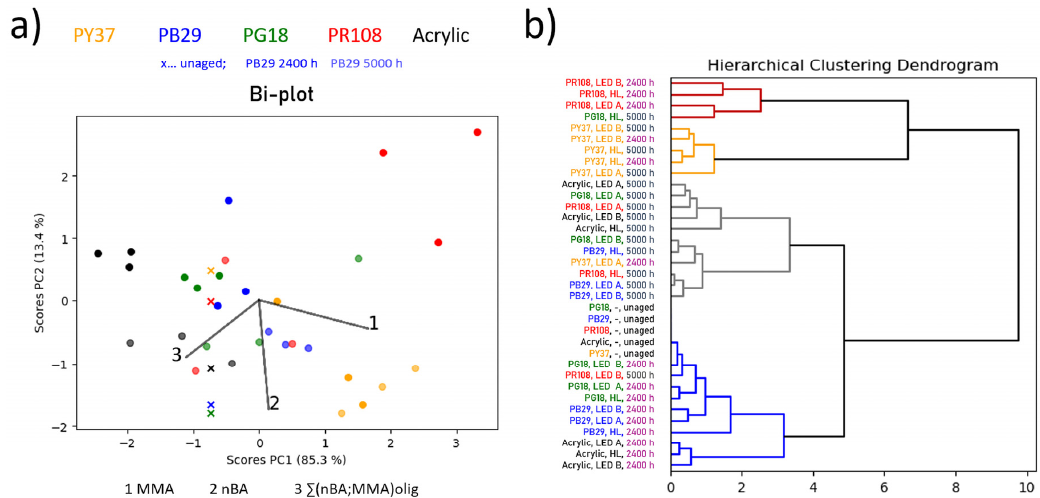
Figure 5. ( a ) Bi-plot (scores and loadings plot of PC1 vs. PC2) for acrylic-based mock-ups. The colour of the scores corresponds to the pigment type (e.g., blue-coloured score = blue pigment; the binder without pigment is depicted in black) and its transparency to the ageing time when exposed to various illuminants (higher transparency indicated longer exposure times; unaged sample is indicated by a cross). ( b ) Dendrogram of the HCA of the PC1 and PC2 scores with the sample names highlighted according to the pigment type or ageing time,